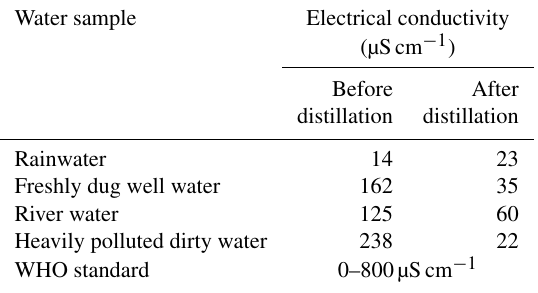
Table 1. Water analyses results before and after desalination. Water